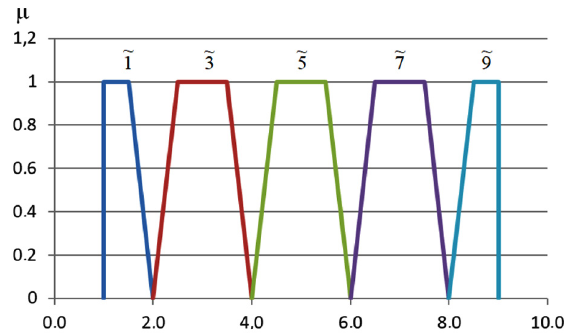
Fig. 1. Membership functions for trapezoidal fuzzy